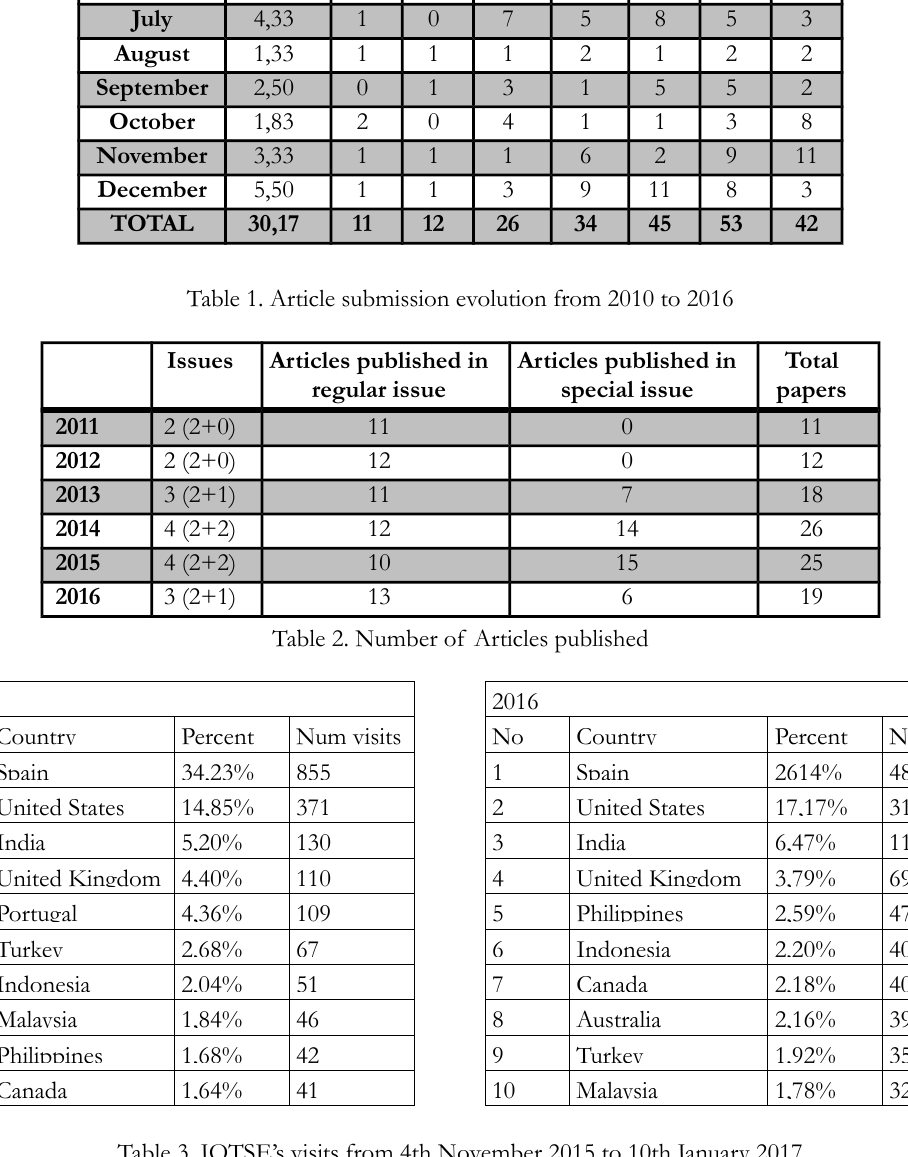
Table 3. JOTSE’s visits from 4th November 2015 to 10th January 2017